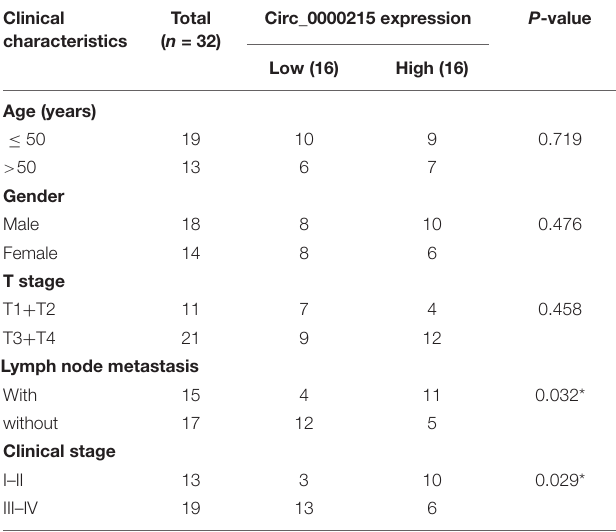
TABLE 1 | Correlation between circ_0000215 expression and the clinicopathological characteristics of 32